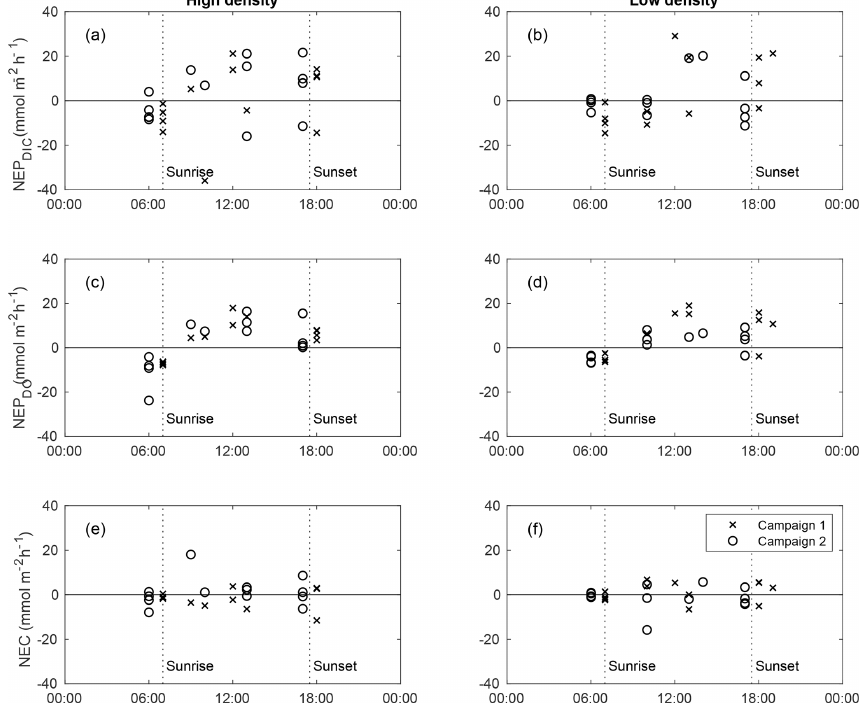
Figure 4. Diel trends in NEP DIC (a–b) , NEP DO (c–d) , and NEC (e–f) for the high-density site (left panels) and low-density site (right panels) for sampling campaign 1 (crosses) and 2 (circles). The x axis represents the midpoint time for each NEP or NEC calculation period.